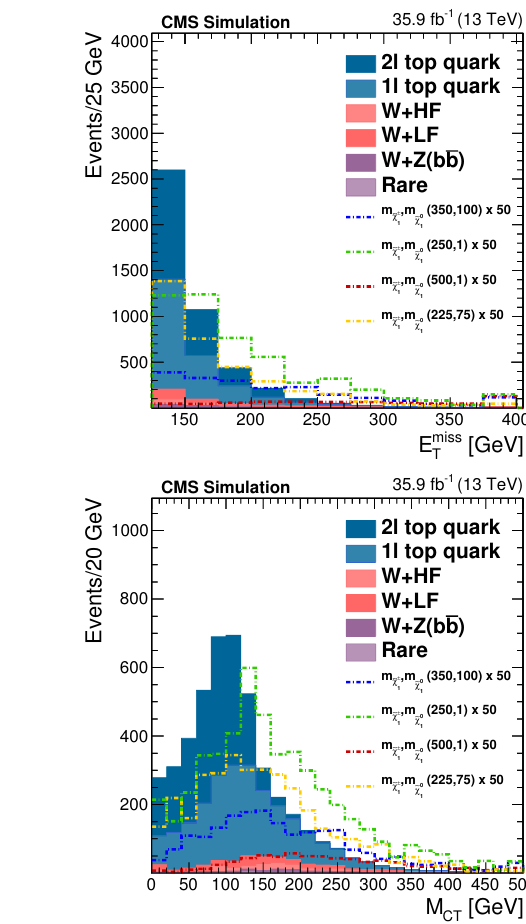
(top left), E miss (top right), M T (bottom left), and M CT (bottom T bb < 150 GeV requirement. Expected signal bb